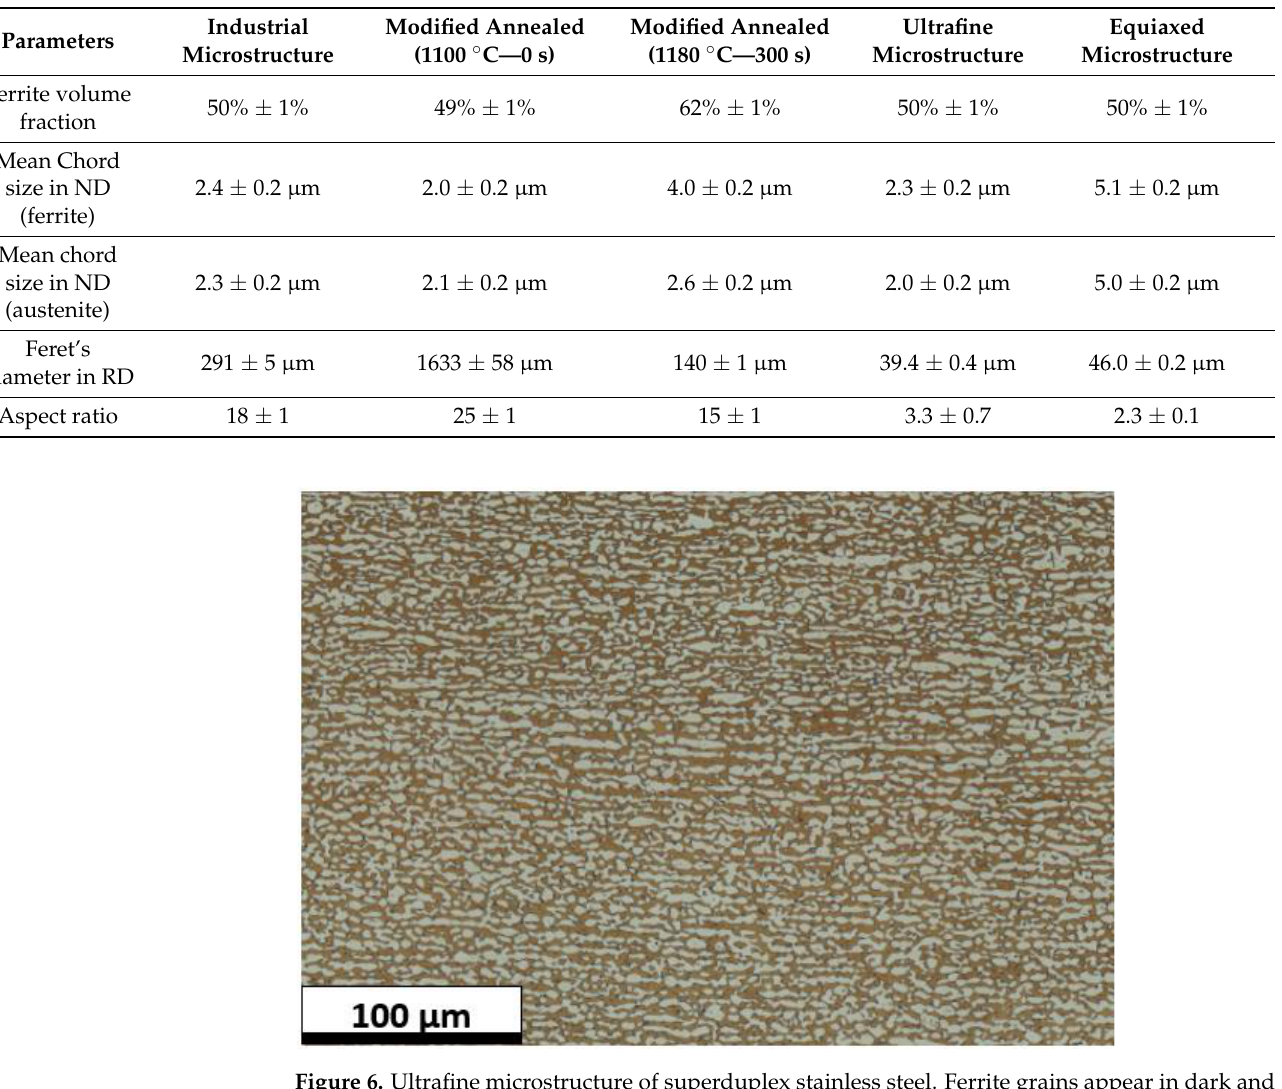
Figure 6. Ultrafine microstructure of superduplex stainless steel. Ferrite grains appear in dark and austenite ones appear in light.